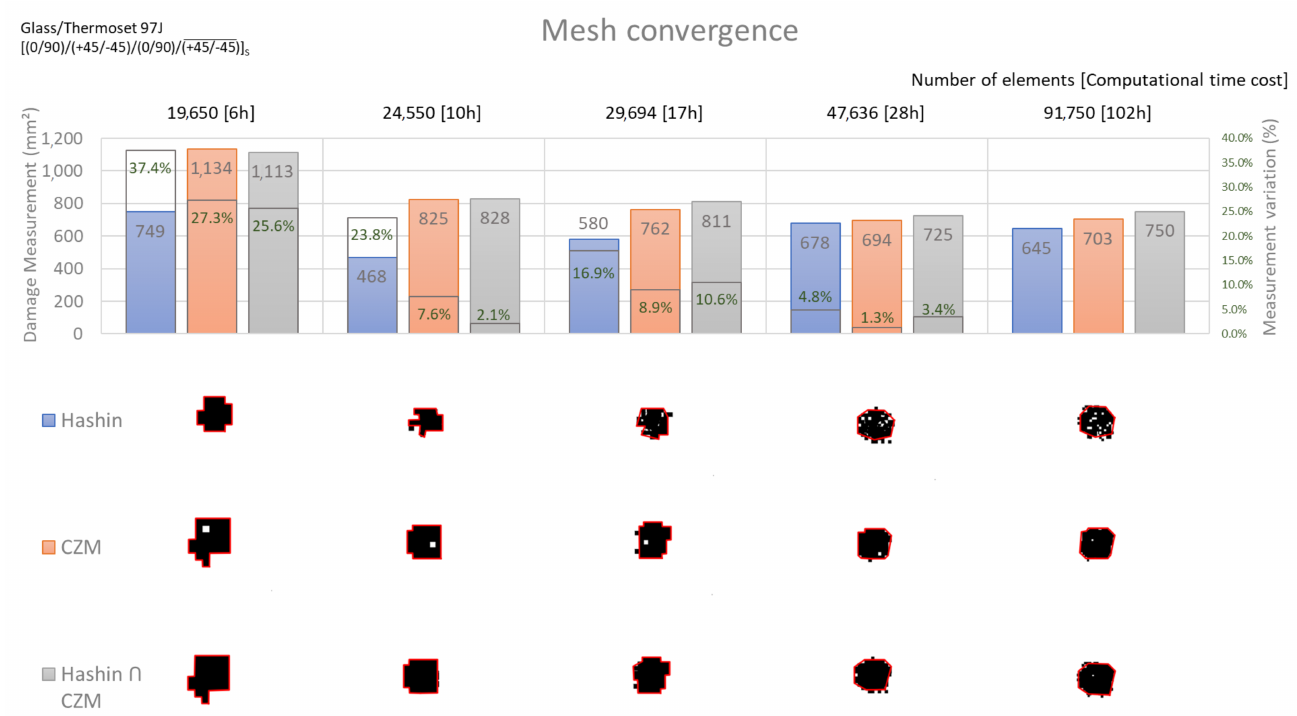
Figure 11. Mesh convergence